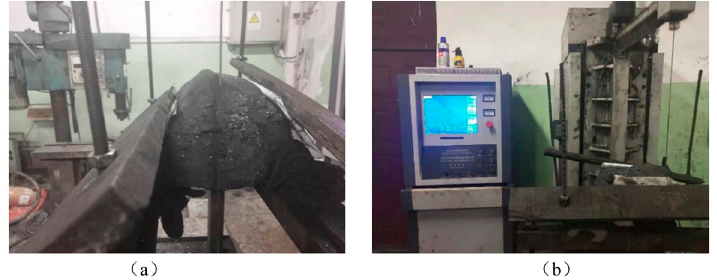
Figure 1. Yarn Cutting Machine ( a ) Fixed coal sample; ( b ) Sample take-up.